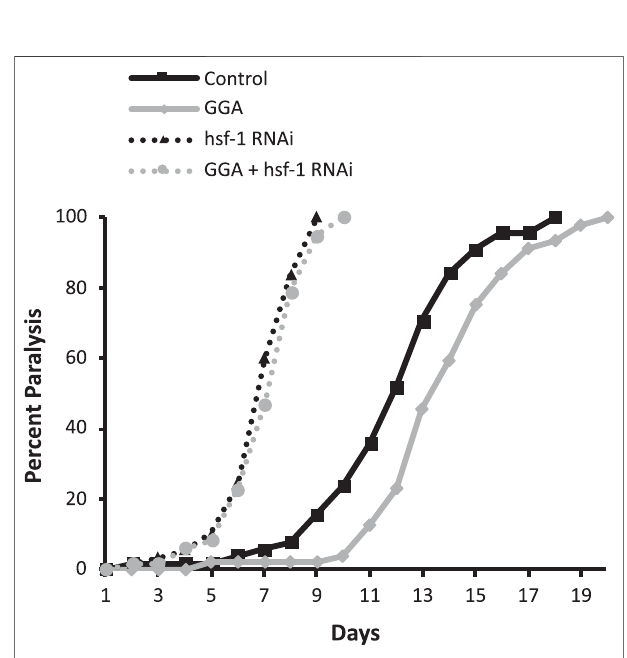
FIGURE 2 | GGAalleviates paralysis in a C. elegans Alzheimer ’ s disease model. Transgenic CL2006 worms expressing beta-amyloid in muscle were synchronized and incubated on NGM control or 10 μ M GGA plates seeded with empty vector (L4440) or hsf-1 RNAi containing bacteria. Worms were scored for paralysis starting at day 1 of adulthood. Worms exposed to GGA had signi fi cantly delayed paralysis compared to control worms (p-value < 0.05, Mantel-Cox log-rank test). Each curve represents data from 3 independent trials of n ≥ 20 individuals.